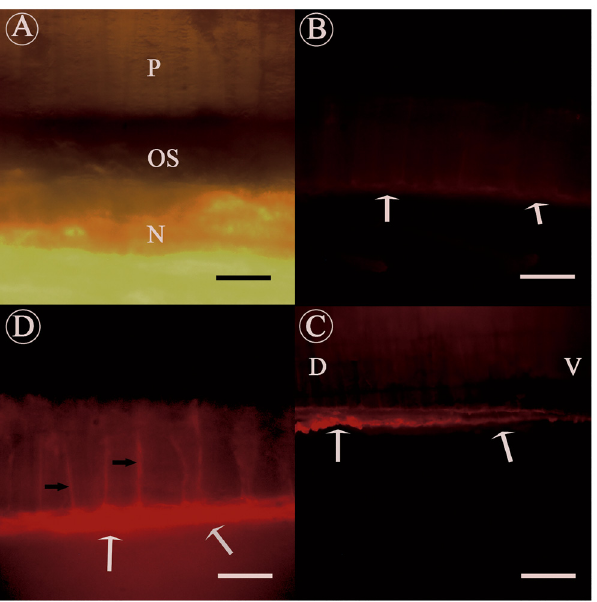
Fig 3. Immunofluorescence localization of native KRMP-3 in the adult shell of P . fucata , with anti- rKRMP-3 antibody. Cleaned and modified shell was decalcified and incubated using anti-rKRMP-3 antibody (C, D) or preimmune serum (B). A, Light micrograph of the shell. The shell presents a representative nacroprismatic microstructure, with columnar calcitic prisms in the upper and nacreous layer in the lower. The two calcified layers are generally separated by an organic layer. P, prismatic layer; N, nacreous layer; OS, organic sheet. B, negative control staining with preimmune serum. The white arrows indicated only a small amount of background staining was detected in the organic sheet. C, staining with anti-rKRMP-3 antibody. The white arrows showed positive signal in the organic sheet. Meanwhile, the positive signal from the ventral to dorsal reflects the distribution of organic sheet; D, dorsal; V, ventral. D, high magnification of the sample. Positive signal detected not only in the organic sheet (white arrows), but also in the prismatic sheath (black arrows). Scale bars in (A, D), 12.5 μ m and in (B, C), 50 μ m.